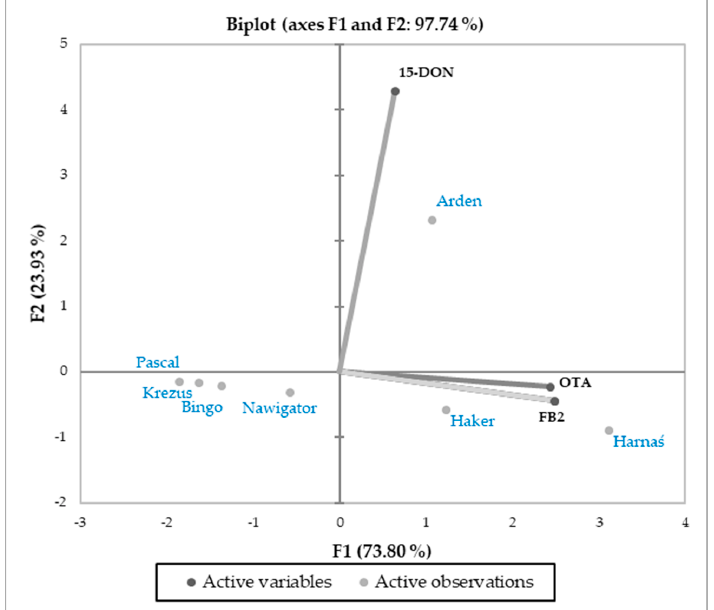
Figure 4. PCA biplot showing the relationships between the mycotoxins contamination of grains of the studied oat cultivars. Ochratoxin A (OTA), fumonisin B1 (FB1), fumonisin B2 (FB2), zearalenone (ZEN), T-2 toxin (T-2), HT-2 toxin (HT-2), deoxynivalenol (DON), 15-acetylodeoxynivalenol (15- DON).